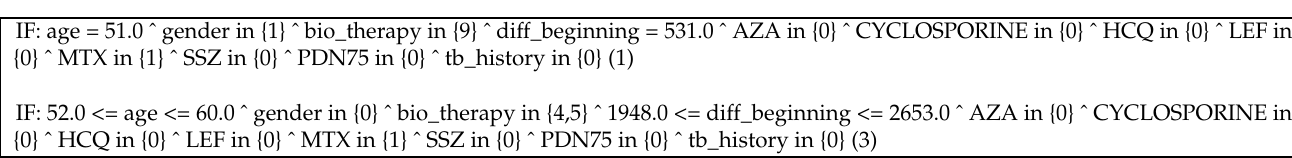
Table 11. Model of rules for patient positivation, obtained with the NNGE algorithm.